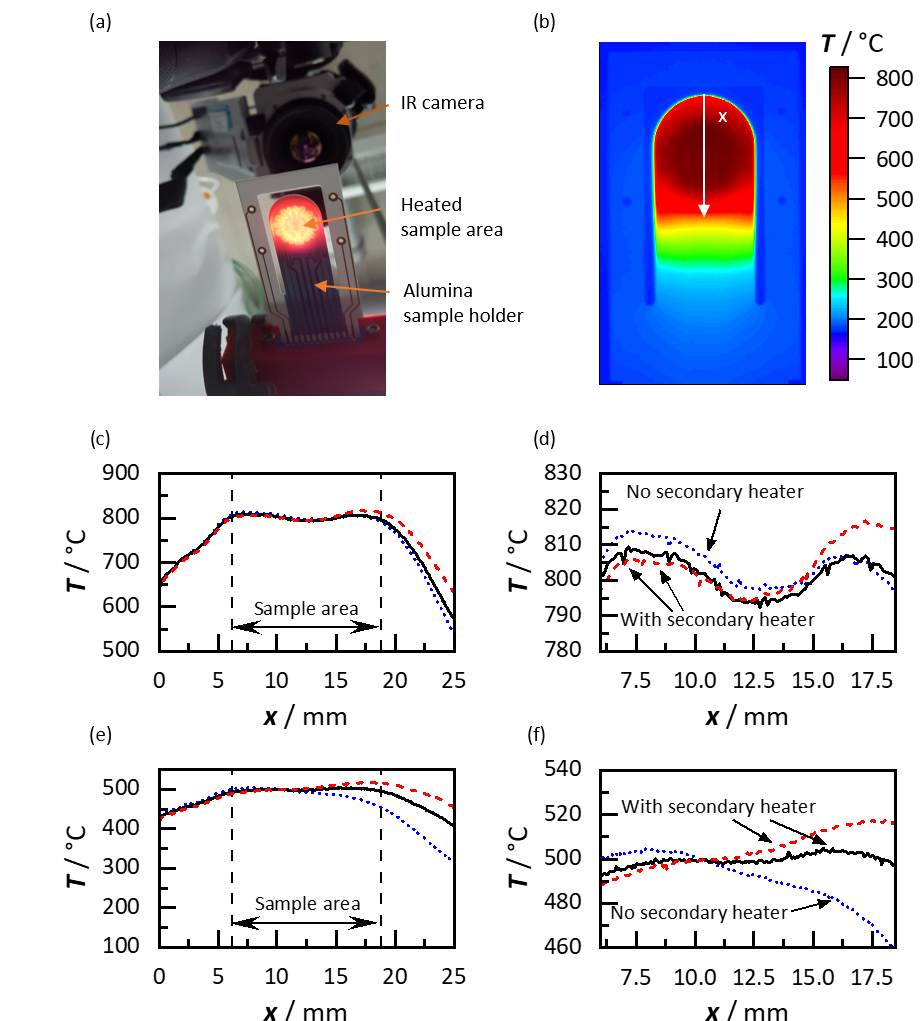
Figure 5. Thermal imaging of the sample holder. (a) Glowing sample area at 800 ◦ C (seen from the bottom side), (b) thermal image at 800 ◦ C with the profile along the x axis for the evaluation of the temperature distribution (topside view), (c) temperature distribution at 800 ◦ C along the x axis (topside view), (d) close view of the temperature distribution within the sample area along the x axis at 800 ◦ C, (e) temperature distribution at 800 ◦ C along the x axis, and (f) close view of the temperature distribution within the sample area along the x axis at 500 ◦ C.